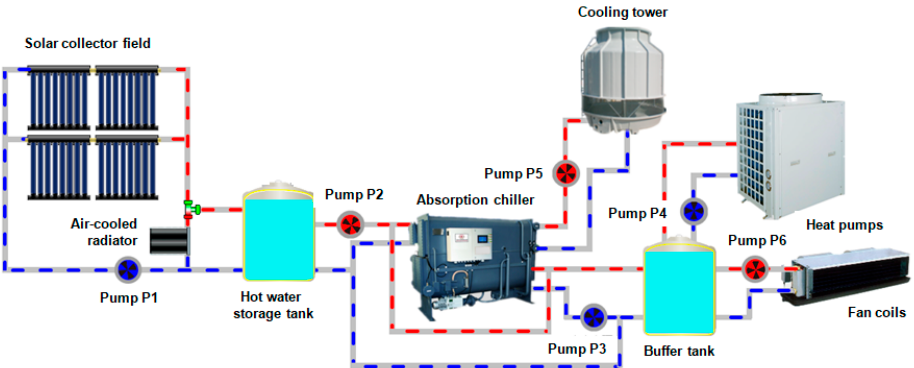
Figure 4. The schematic of the solar thermal cooling and heating system.